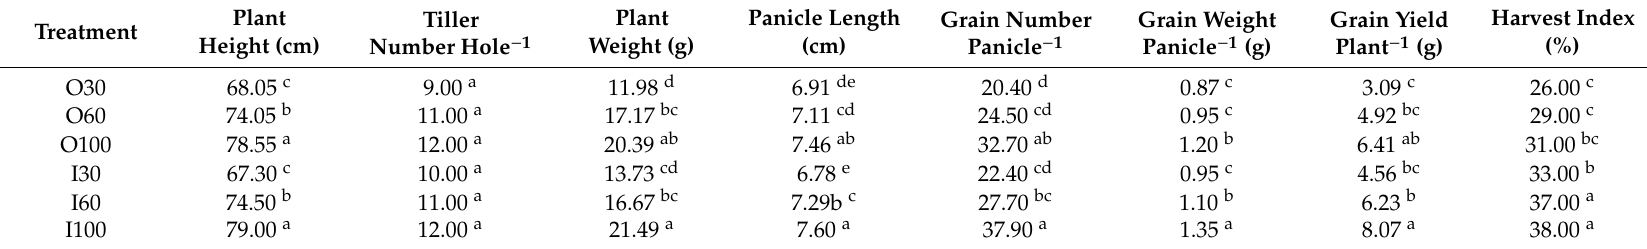
Table 3. Mean comparison of growth and yield components of wheat under di ff erent regimes of fertilizer and soil